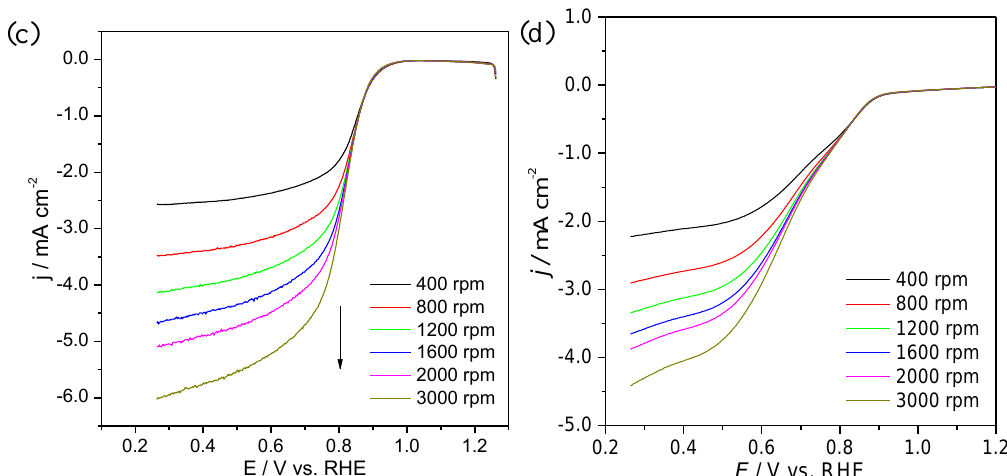
Figure 7. ORR polarization curves at different rotation rates in O 2 -saturated 0.1 mol dm -3 KOH solution at 0.005 V s -1 for S 3 N 2 –GF ( a ), Co/S 3 N 2 –GF ( b ), Mn/S 3 N 2 –GF ( c ) and commercial Pt/C (20wt%) modified electrodes ( d ).